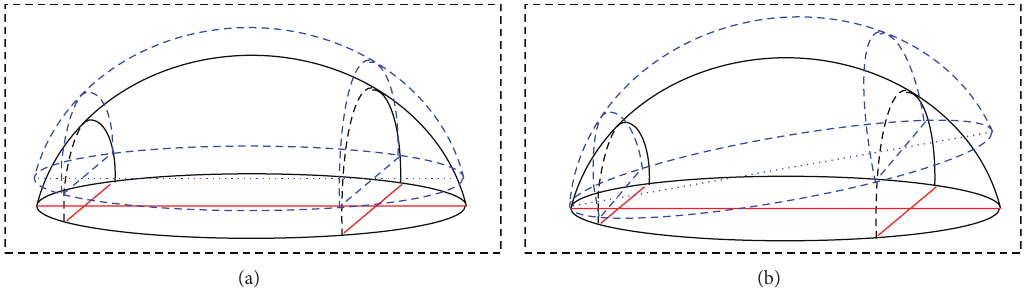
Figure 5: Effect of displacement due to (a) translation and (b) rotation on the ROC measurement during testing, where solid line represents the idea position and dotted line represents the actual position.